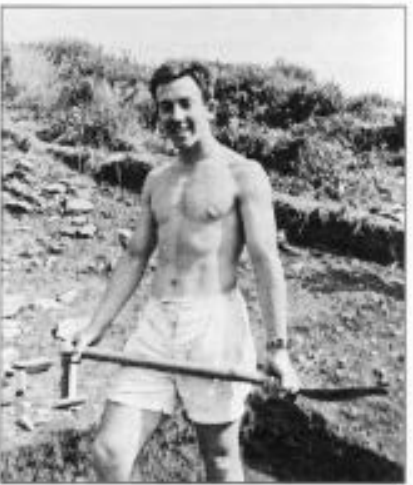
Age site that was being examined by Professor Crimes, summer